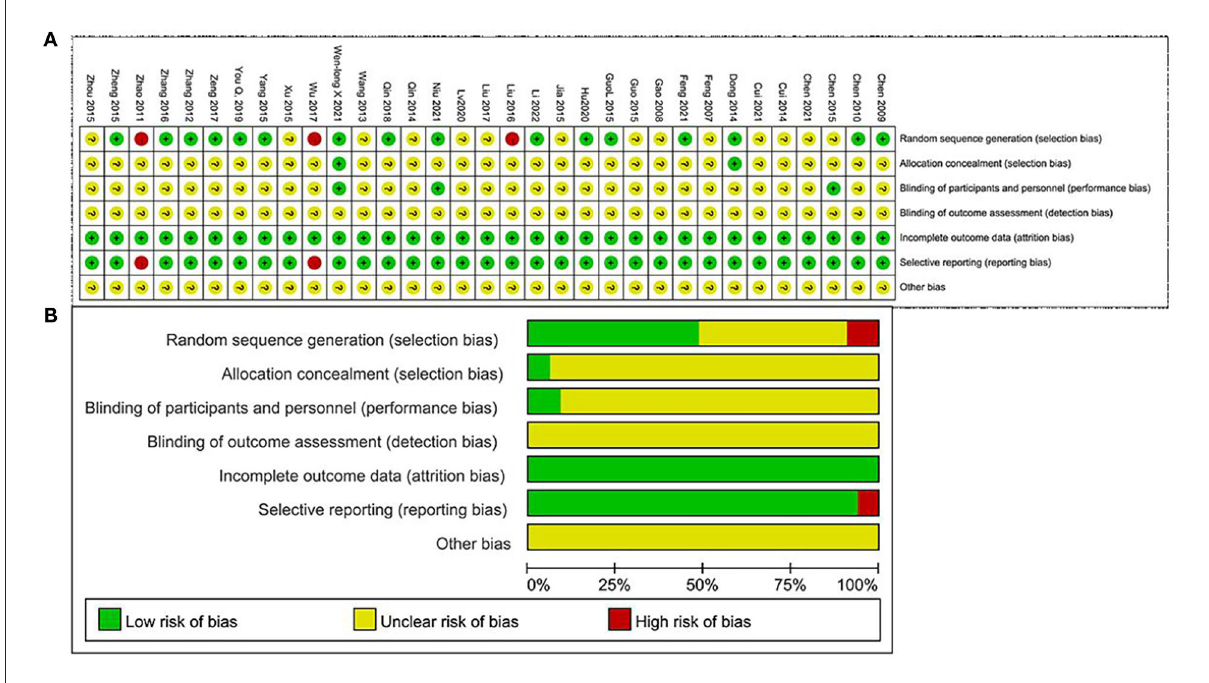
FIGURE2 (A) Risk-of-bias summary. (B) Risk-of-bias